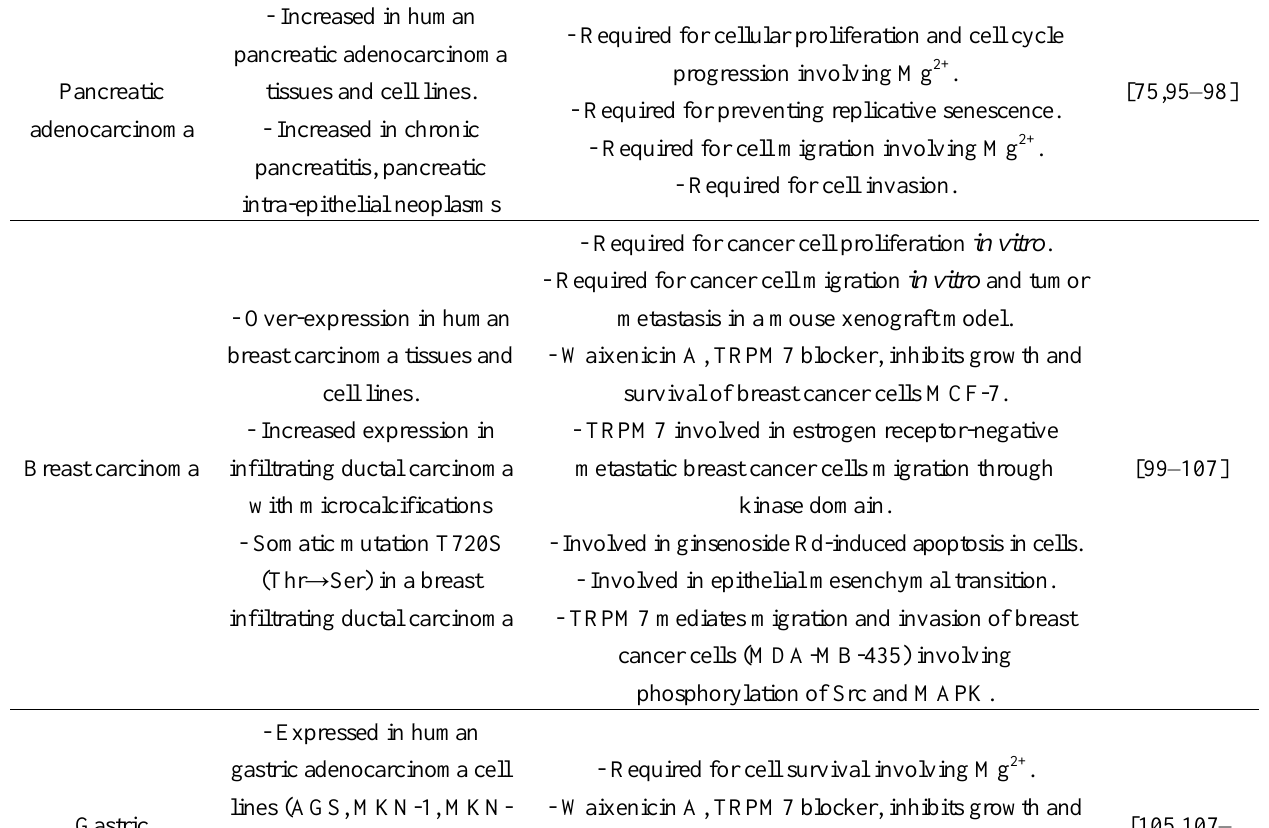
Table 4. Expression and roles of TRPM7 channels in various human malignancies.